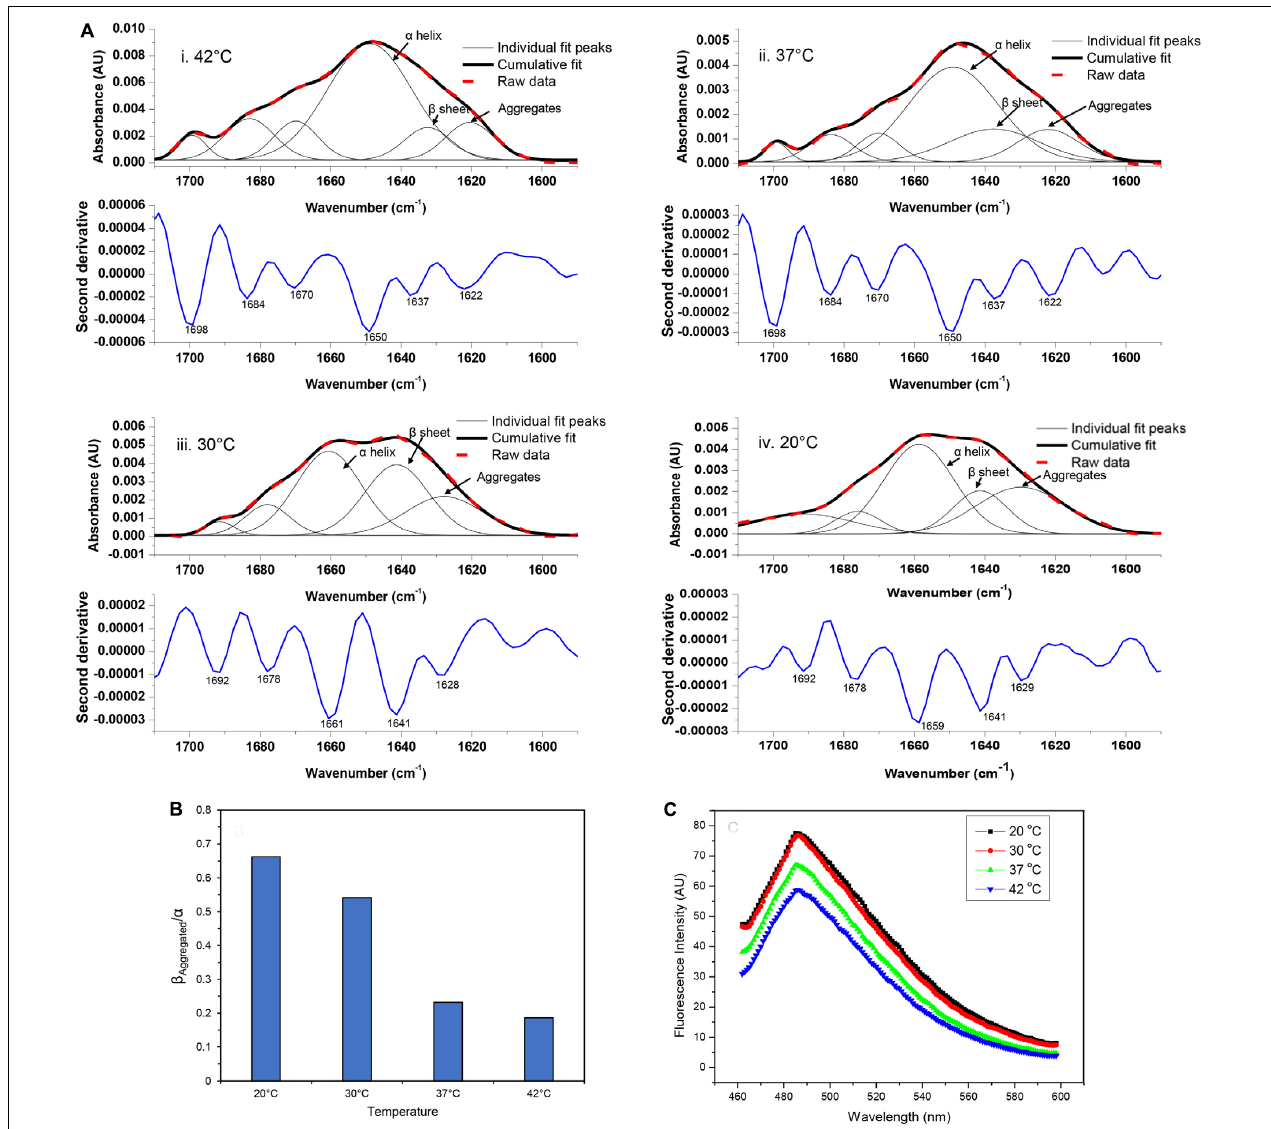
FIGURE 3 | Amyloid content in asparaginase inclusion bodies. (A) Amide I FTIR spectra of asparaginase inclusion bodies induced at different temperatures (i. 42 ◦ C, ii. 37 ◦ C, iii. 30 ◦ C, and iv. 20 ◦ C). Second derivatives of Fourier self-deconvoluted spectra (shown in blue lines, labeled minima values are in cm - 1 ) were used to identify and assign major structural components. With help of the identified peaks, curve fitting of amide I band spectra was performed to obtain individual curves for the secondary structure components. Raw data (bold red dashed lines), cumulative fits (bold black lines), and individual peak components (black lines) are shown above the respective second derivatives. The component bands assigned as alpha-helix ( α helix), beta sheet in native structure ( β sheet), and beta structure present in amyloid aggregates (Aggregates) are pointed out with black arrows. (B) Ratio of beta structure present in amyloid aggregates and alpha helical component ( β Aggregated / α ) was used as a measure of amyloid content present in asparaginase inclusion bodies expressed at different temperatures. (C) Comparison of amyloid content in asparaginase inclusion bodies expressed at different temperatures using Thioflavin T